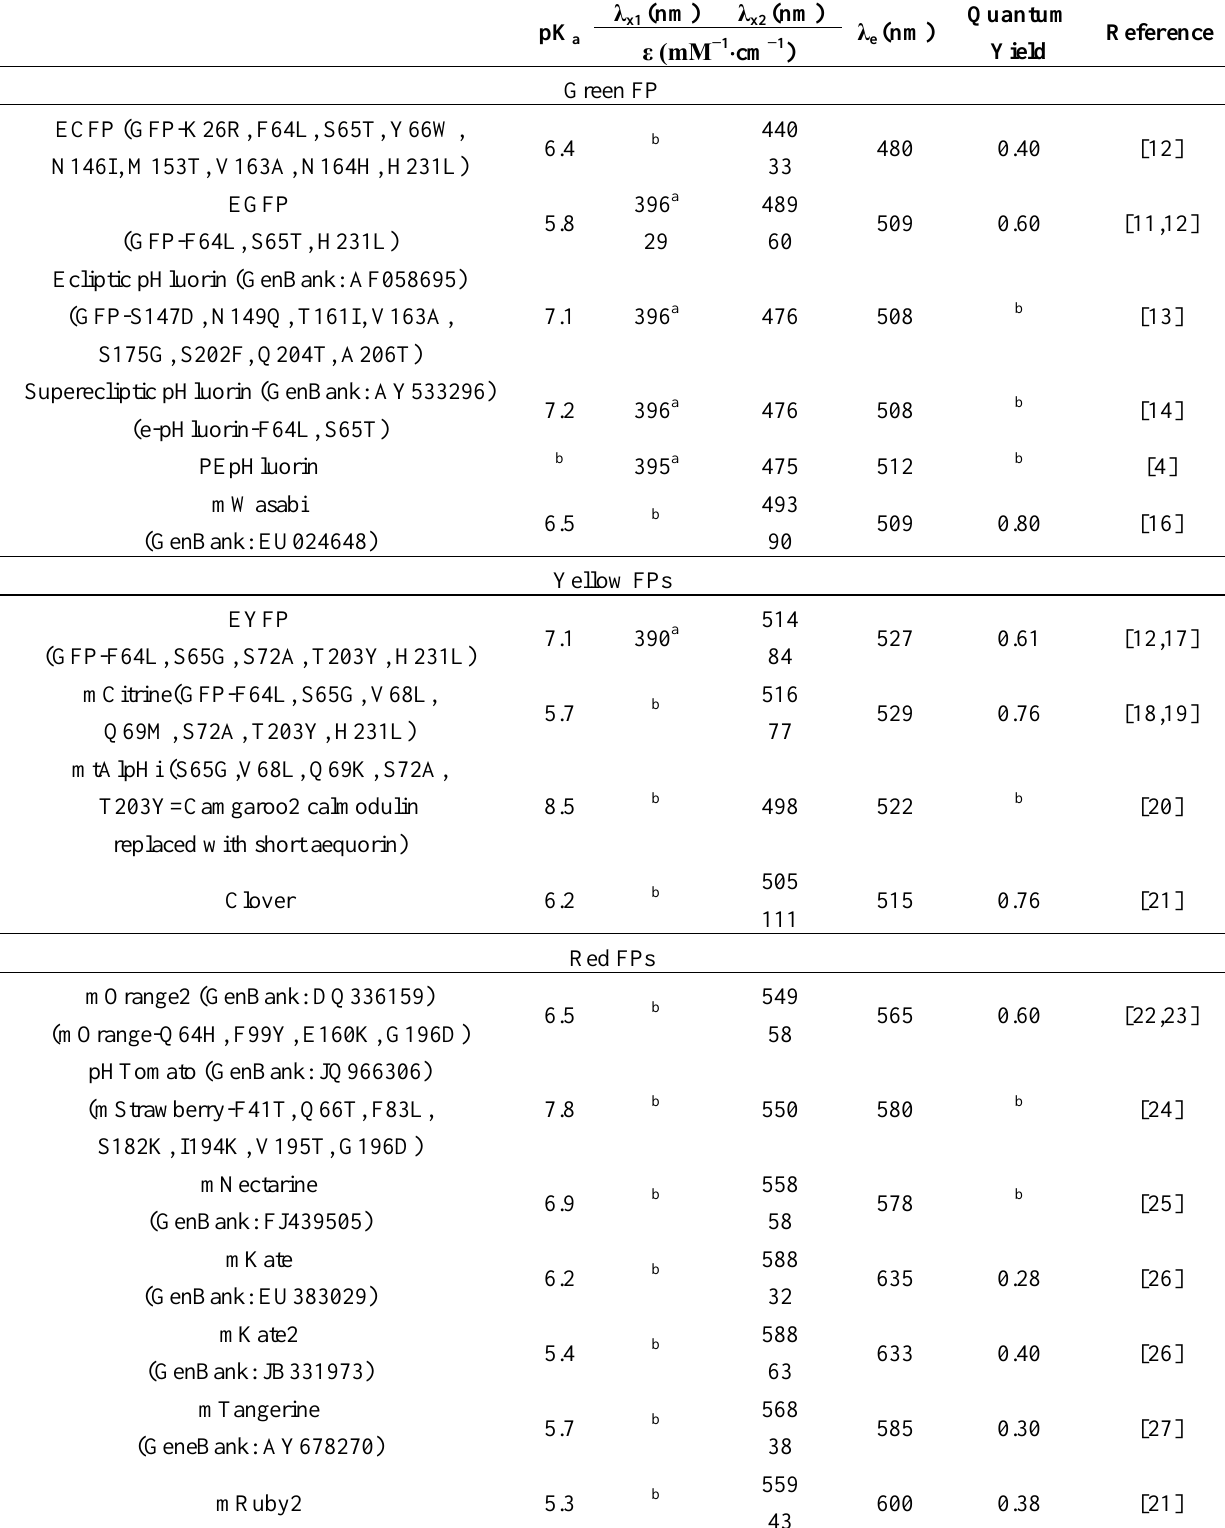
Table 1. Intensity-based pH-sensitive fluorescent